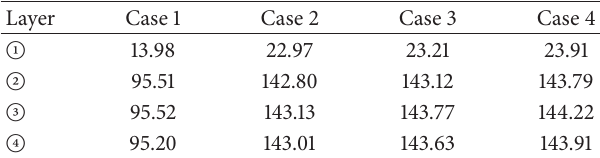
Table 3: Tension forces of the cables under different degrees of the coherence